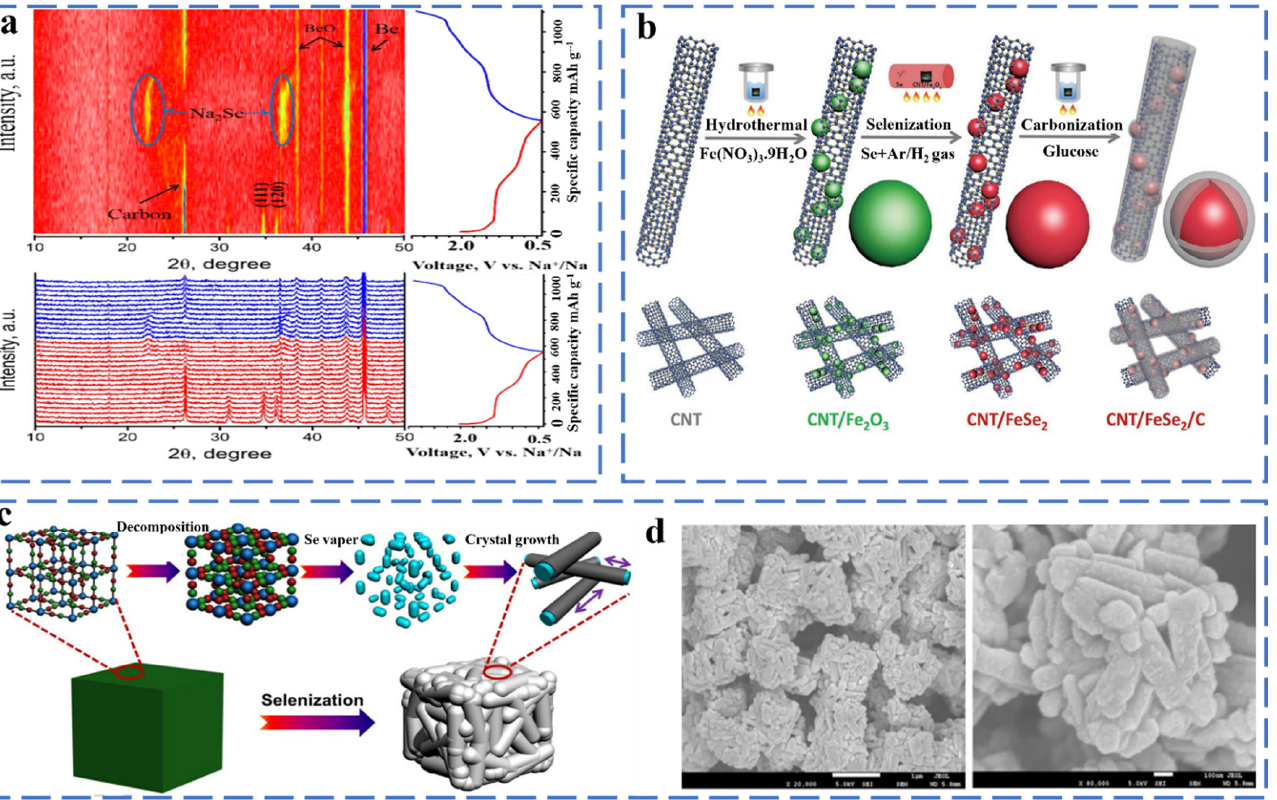
Figure 2. ( a ) In situ XRD results contour plot and corresponding in situ XRD patterns and dis- charge/charge curves of FeSe 2 @NC MR electrode during initial cycling. Reprinted with permission from Ref. [34]. Copyright 2020, copyright Pan, Q. ( b ) Preparation process of CNT/FeSe 2 /C. Reprinted with permission from Ref. [35]. Copyright 2020, copyright Yousaf, M. ( c ) The formation mechanism of 3D hierarchical iron selenide hollow nanocubes assembled from FeSe 2 @C core–shell nanorods, ( d ) SEM images. Reprinted with permission from Ref. [36]. Copyright 2018, copyright Fan, H.